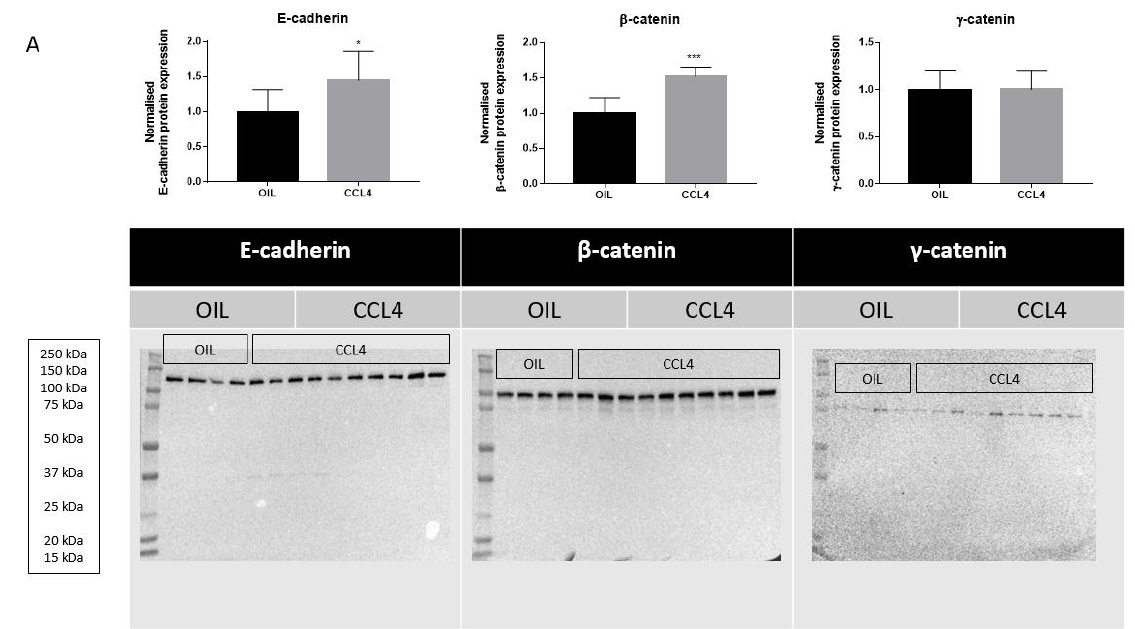
Figure 3(A): Effects of chronic liver disease on protein levels of hepatic cell junction